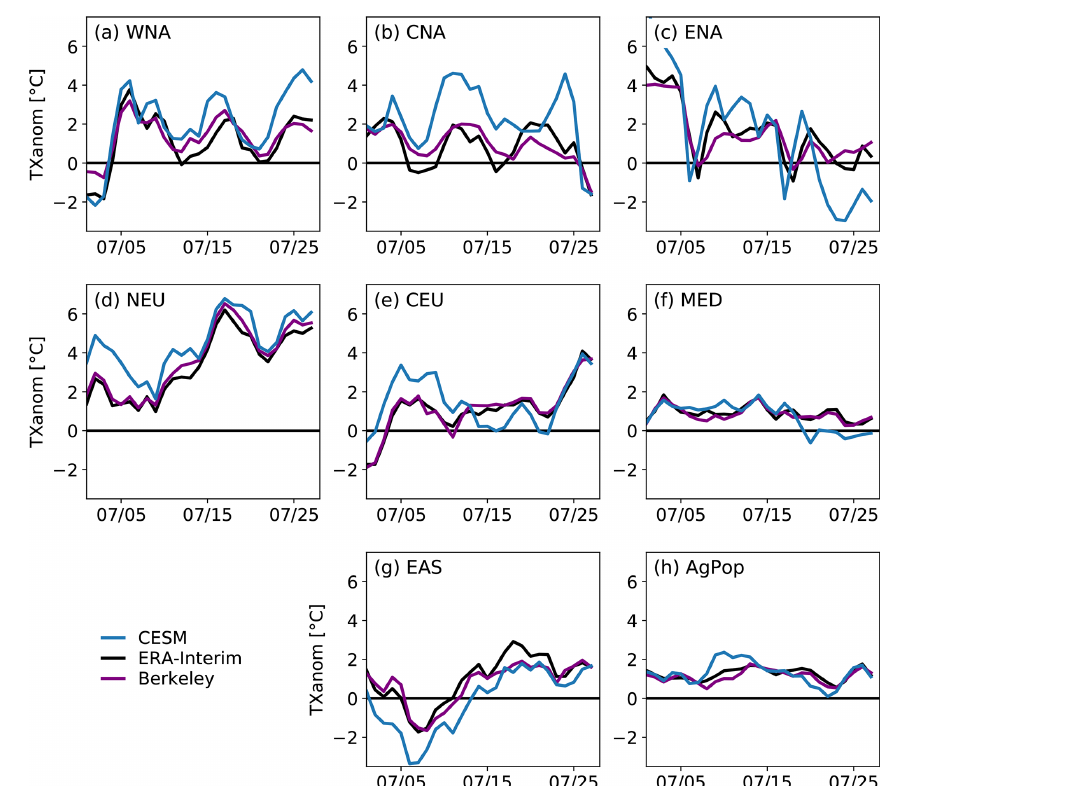
Figure A4. Time series showing the anomaly of maximum daily temperature (TXanom) for July 2018 averaged for (a–g) seven SREX regions and (h) the AgPop region. Shown are the historical simulation from CESM (blue), ERA-Interim (black) and Berkeley (violet). The reference climatology is 1981–2010.